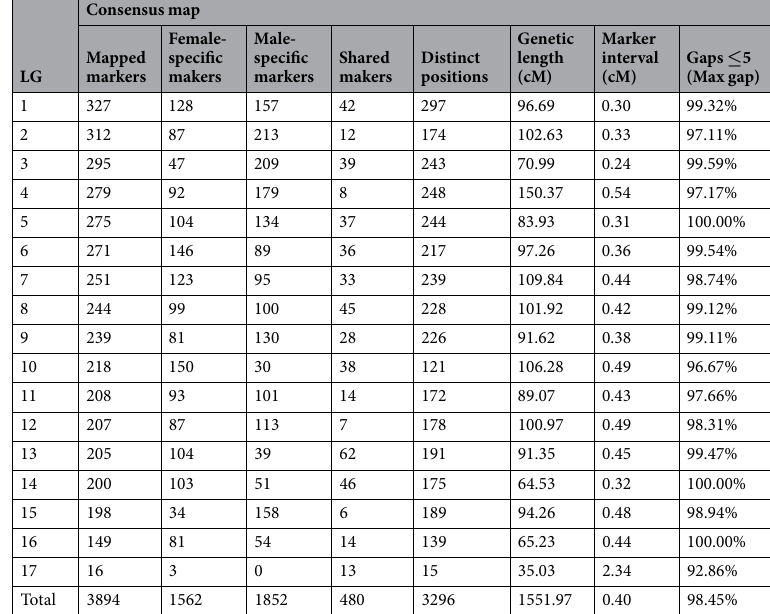
Table 4. Summary of the consensus linkage map of Hawthorn.